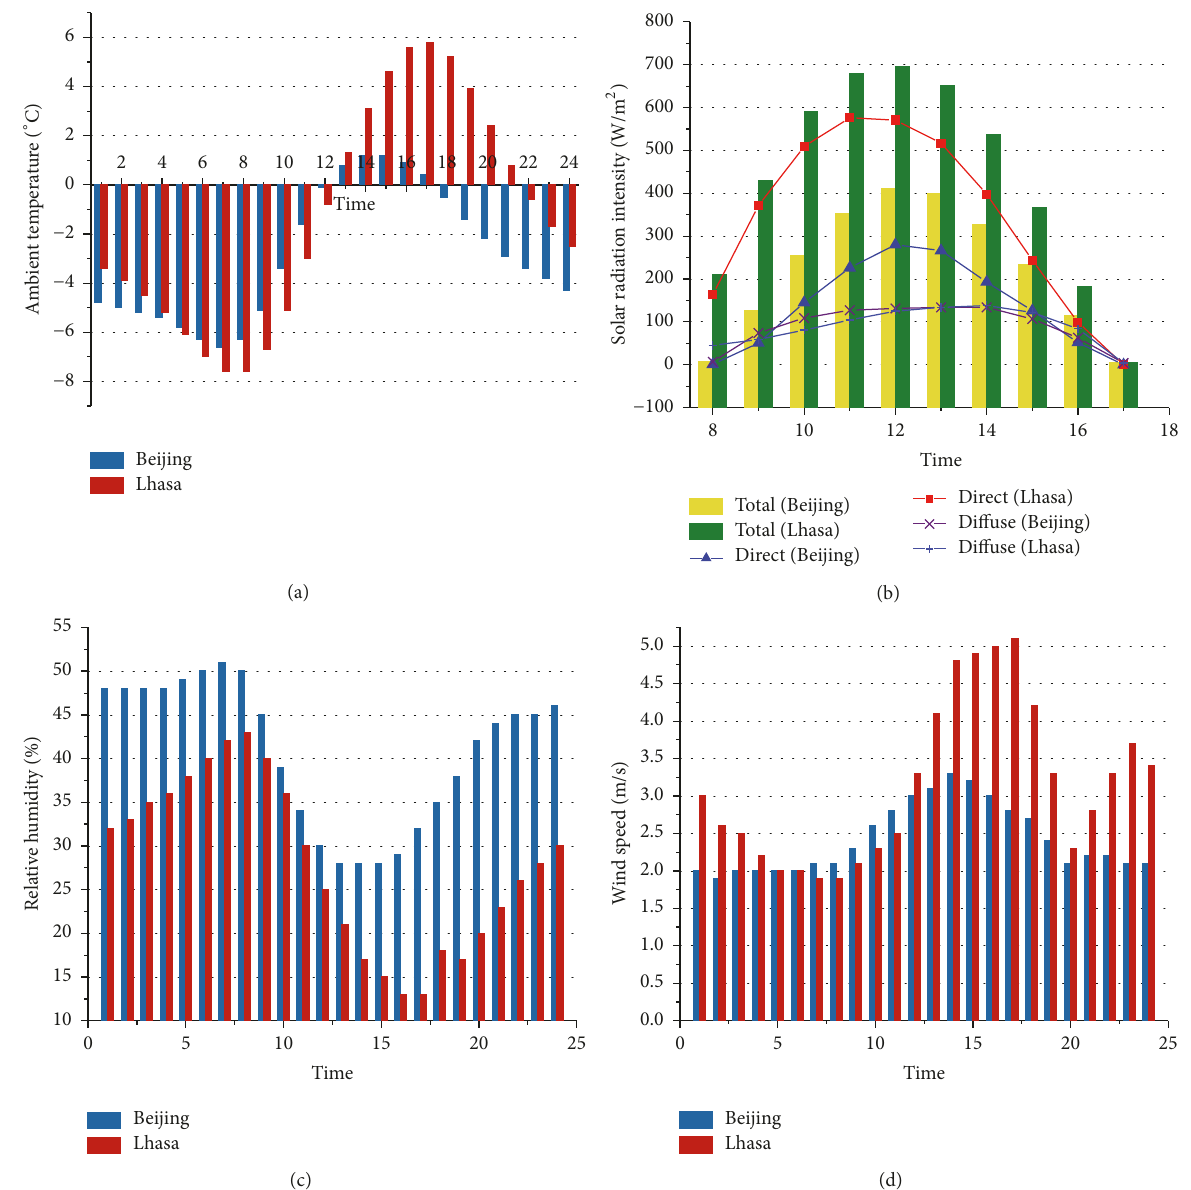
Figure 1: Comparison of the outdoor climate condition between Beijing and Lhasa in the typical day in January. (a) Temperature; (b) solar radiation; (c) relative humidity; (d) wind speed.